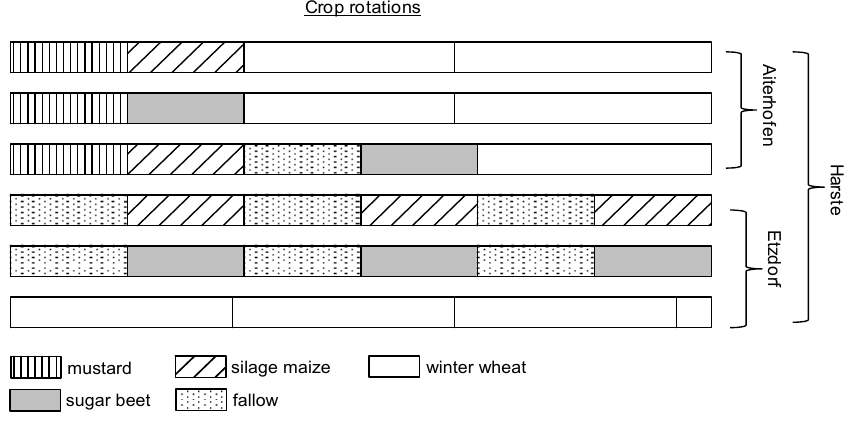
Figure 2. Crop rotations and continuous cultivation at sites investigated.